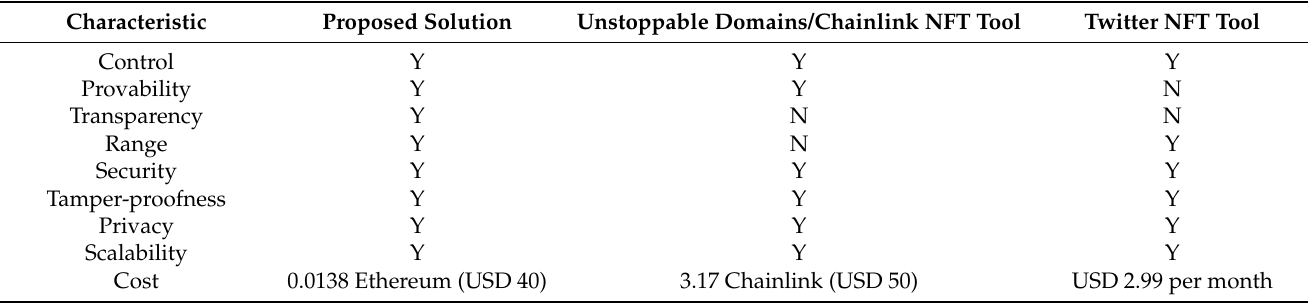
Table 2. Digital identity: application